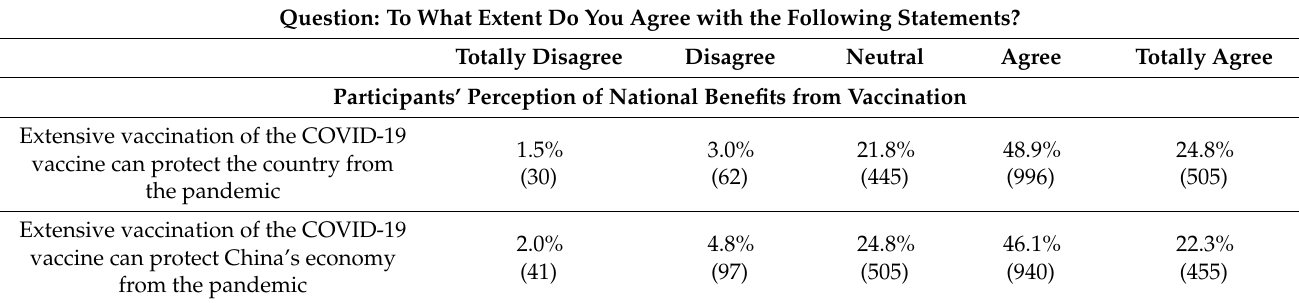
Table 6. Participants’ perception of national benefits from vaccination ( n = 2038).